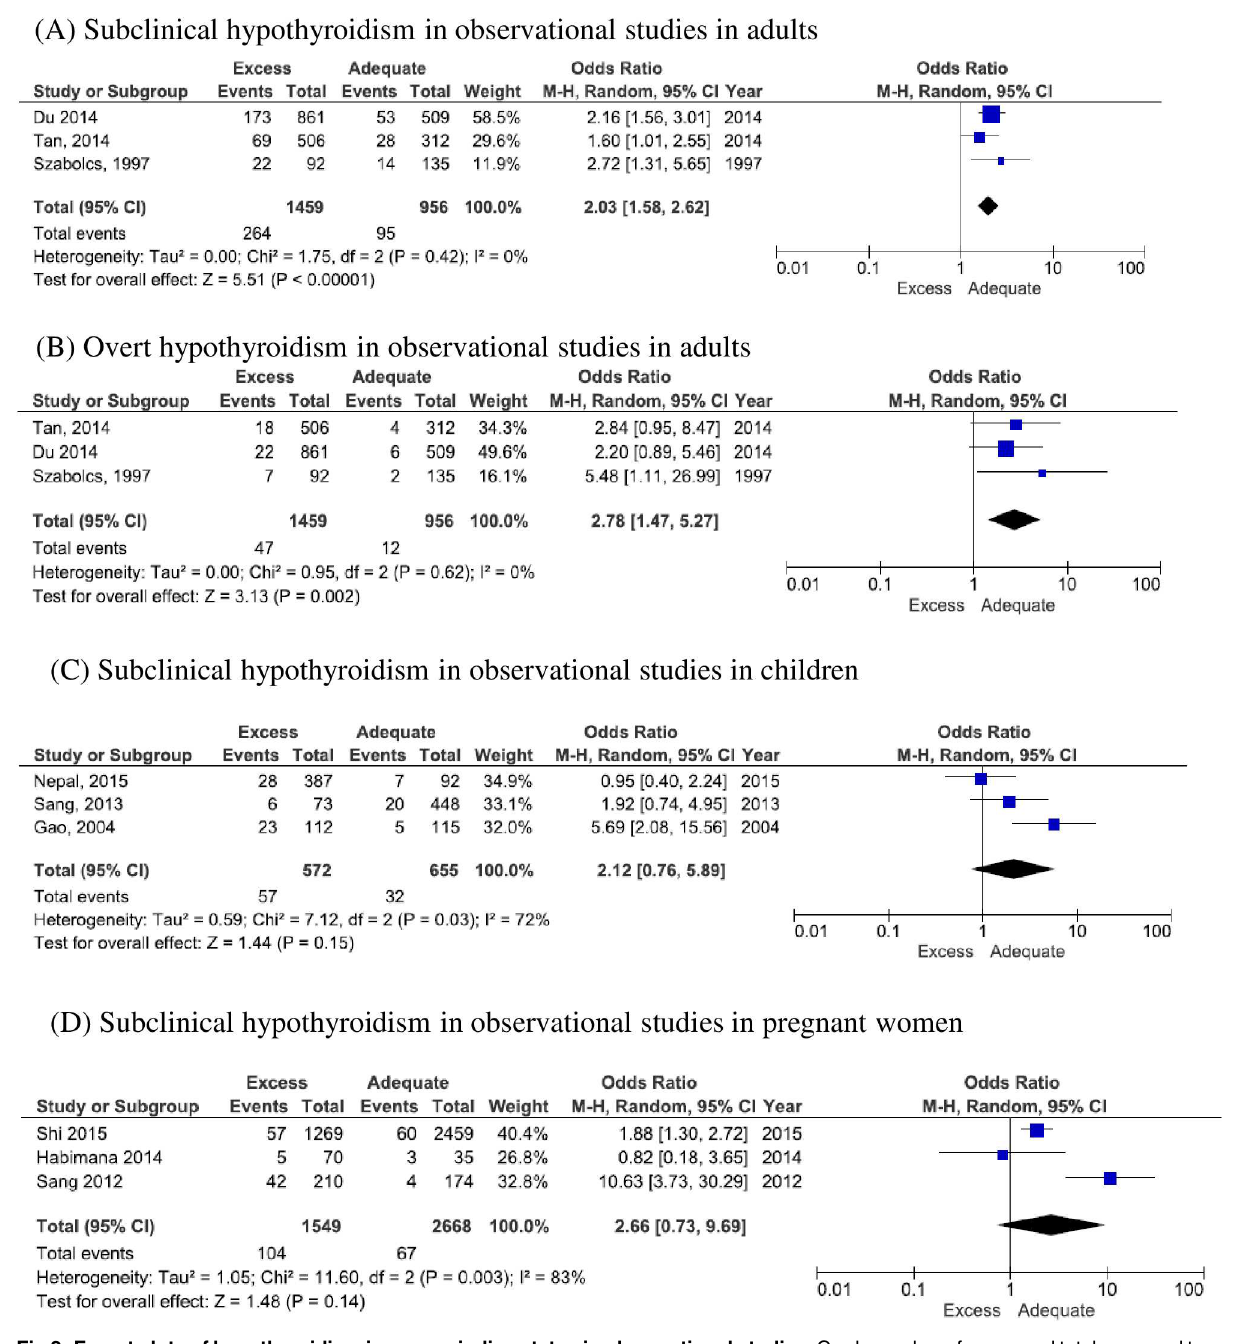
Fig 2. Forest plots of hypothyroidism in excessiodine status in observational studies. Crude number of cases and total was used to calculateodds ratio in each study. Adults [35–37],children[43–45],and pregnantwomen [66–68]were includedin this